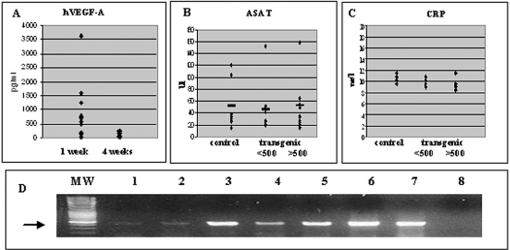
Expression of human and mouse VEGF-A after AdCre gene transfer in vivo.A. hVEGF-A165 ELISA from sera after AdCre gene transfer.B. ASAT values in transgenic and control mice after AdCre gene transfer.C. CRP values in transgenic and control mice after AdCre gene transfer.D. Expression of hVEGF-A165 mRNA using RT-PCR.Lanes; 1 = Aorta, 2 = pancreas, 3 = kidney, 4 = heart, 5 = spleen, 6 = liver, 7 = positive control and 8 = liver without RT (500 bp pointed with an arrow).<500 and >500 in B and C refer to hVEGF-A165 serum levels in two subgroups of transgenic mice.